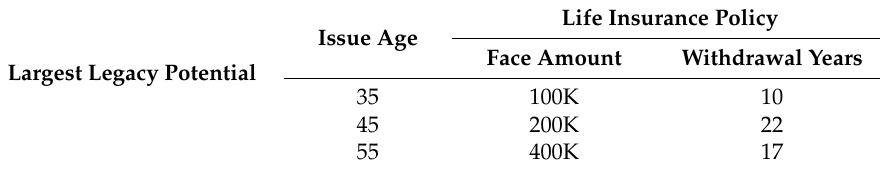
Table 6. Insurance parameters that yield the highest legacy potential.